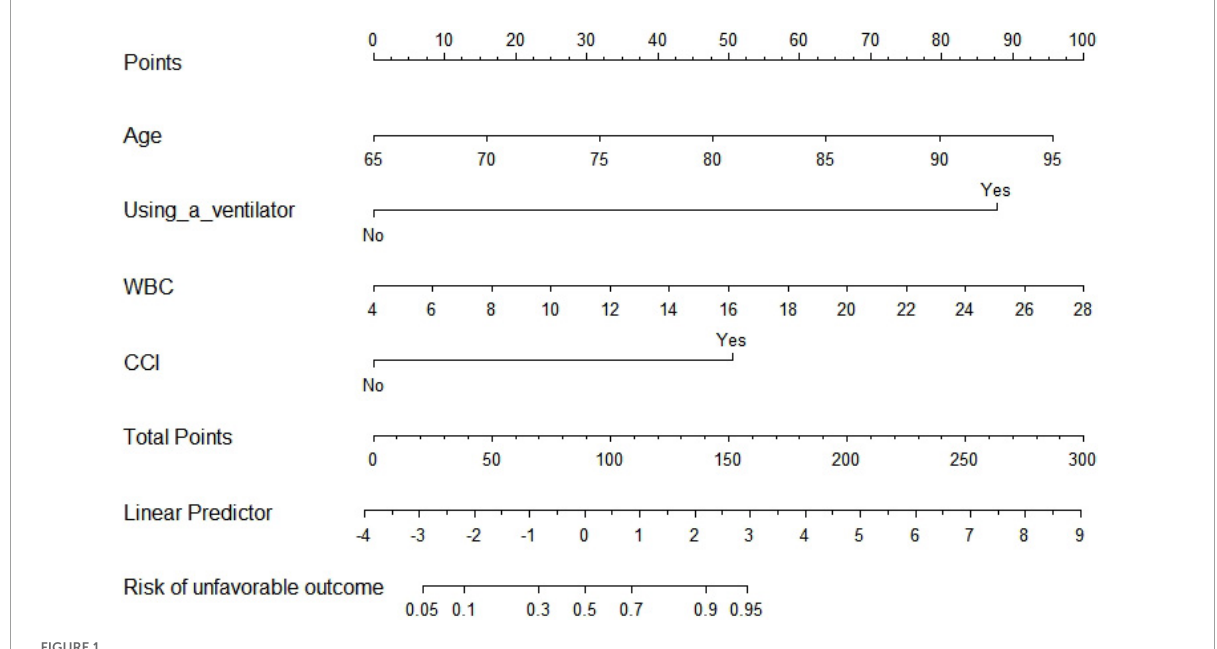
FIGURE1 Traditional nomogram for predicting 6-month unfavorable outcome in elderly cohort with aneurysmal subarachnoid hemorrhage (aSAH) treated by endovascular coiling. WBC, white blood cell count; CCI, complicated with cerebral infarction.